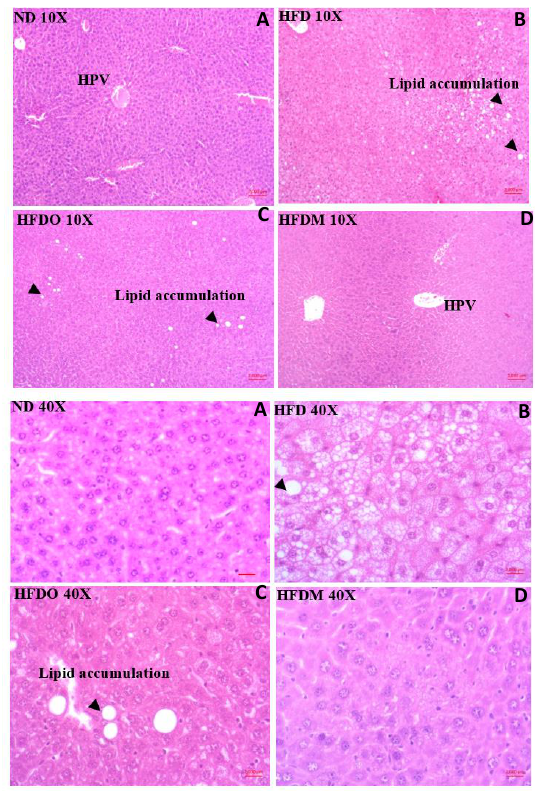
Figure 10. Effect of high-fat diet on fat deposition in the HFD-fed obese mice at 10x and 40x magnifications. Treatment with MESK completely prevented hepatic lipid deposition and hepatic ballooning. (A: ND: normal diet, B: HFD: high-fat diet, C: HFDO: HFD + Orlistat, D: HFDM: HFD + MESK). HPV: Hepatic portal vein, Lipid accumulation: fat droplets. Scale bar indicates 2000 µm.